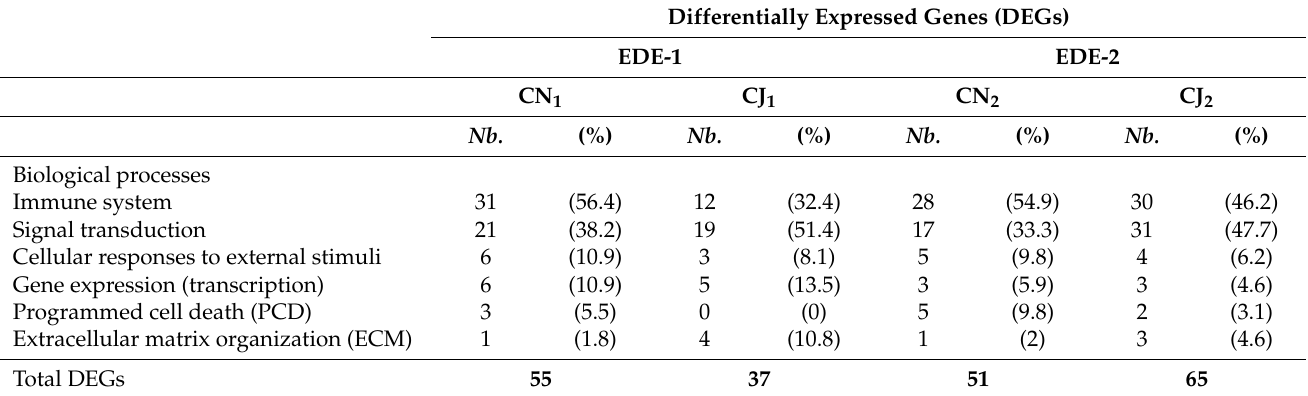
Table 3. Overview of biological processes and current targets involved in both human disease and experimental mouse